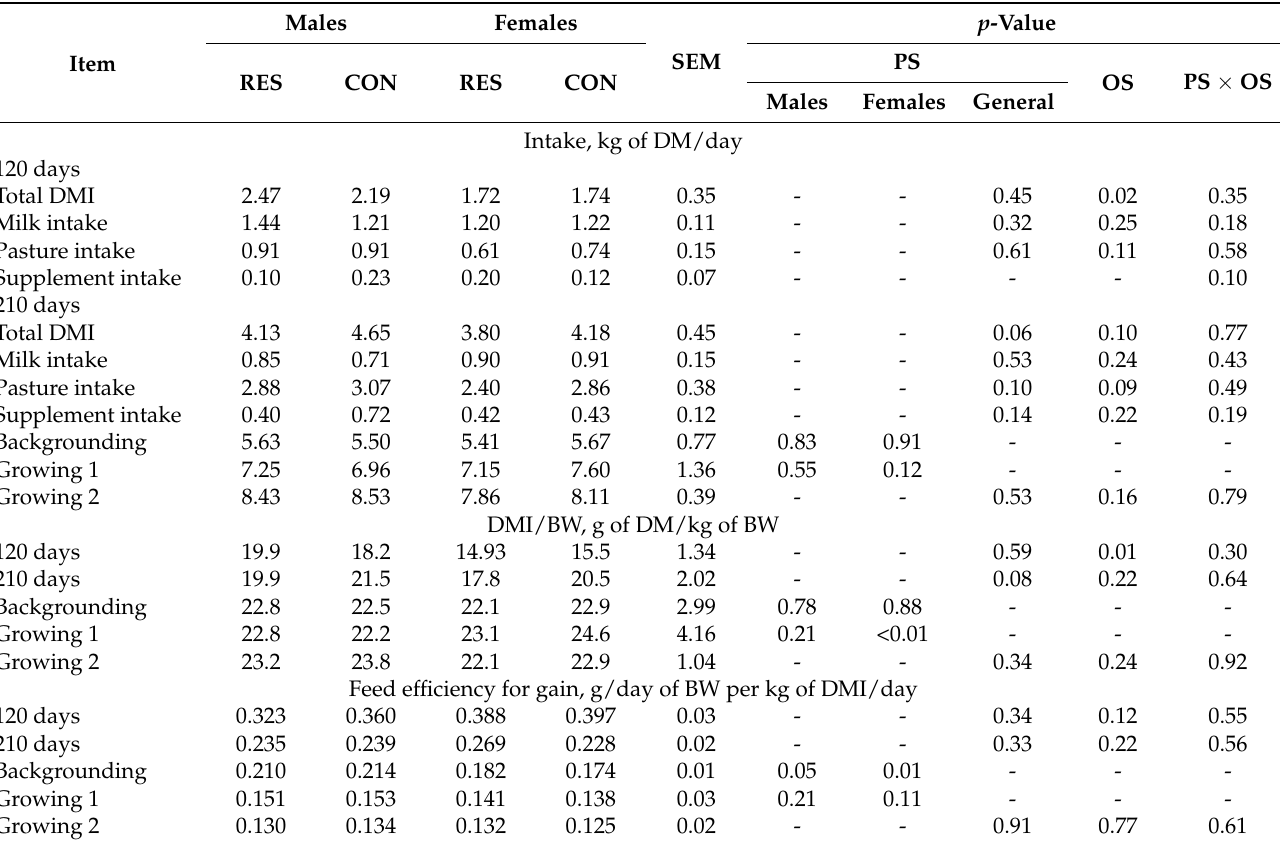
Table 3. Effects of maternal protein supplementation status (PS) and offspring sex (OS) on the intake and DMI/kg of BW during the cow–calf and feedlot